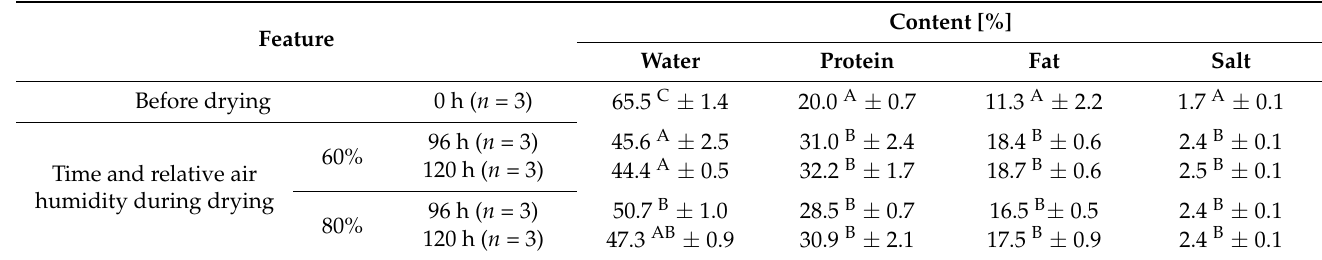
Table 5. Chemical composition of KSS sausages (mean ± standard